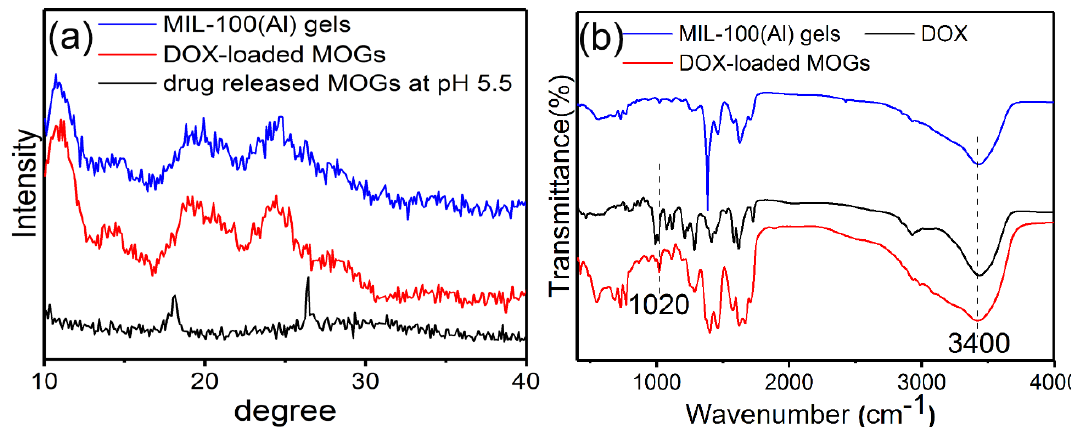
Figure 2. ( a ) Powder XRD patterns of MIL-100(Al) gels, DOX-loaded MOGs, and drug-released MOGs at pH 5.5; ( b ) FTIR spectra of MIL-100(Al) gels, DOX, and DOX-loaded MOGs.